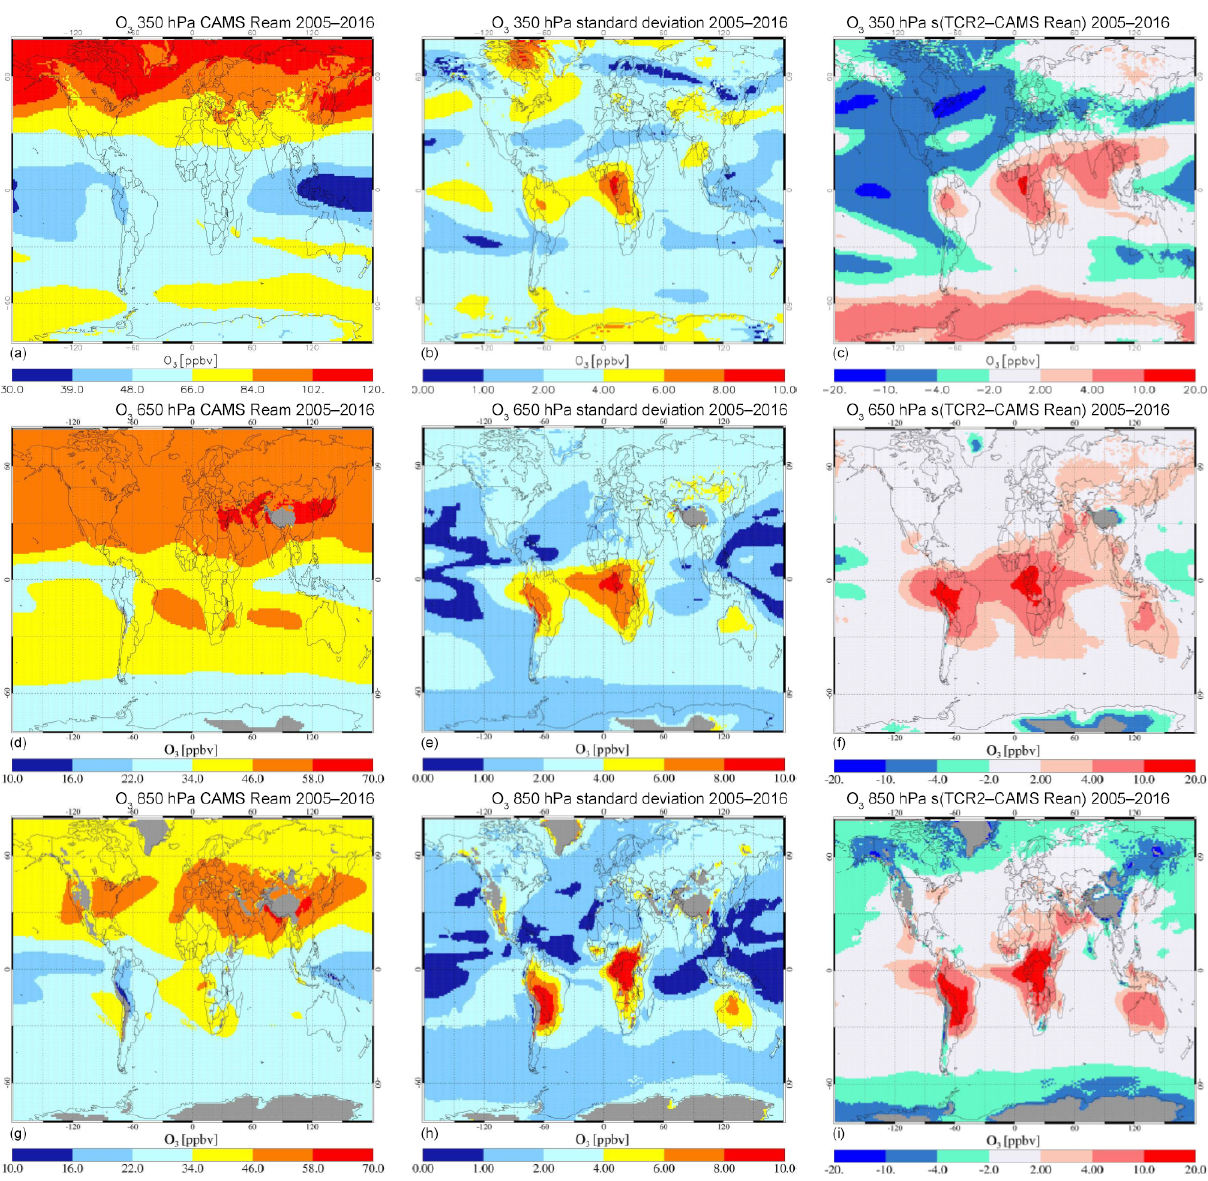
Figure 14. (a, d, g) Multiannual mean O 3 at 350, 650, and 850hPa for the CAMS Reanalysis at 650hPa over 2005–2016. (b, e, h) SD in the multiannual means for the four reanalyses. (c, f, i) Absolute difference between TCR-2 and CAMS Reanalysis (all in